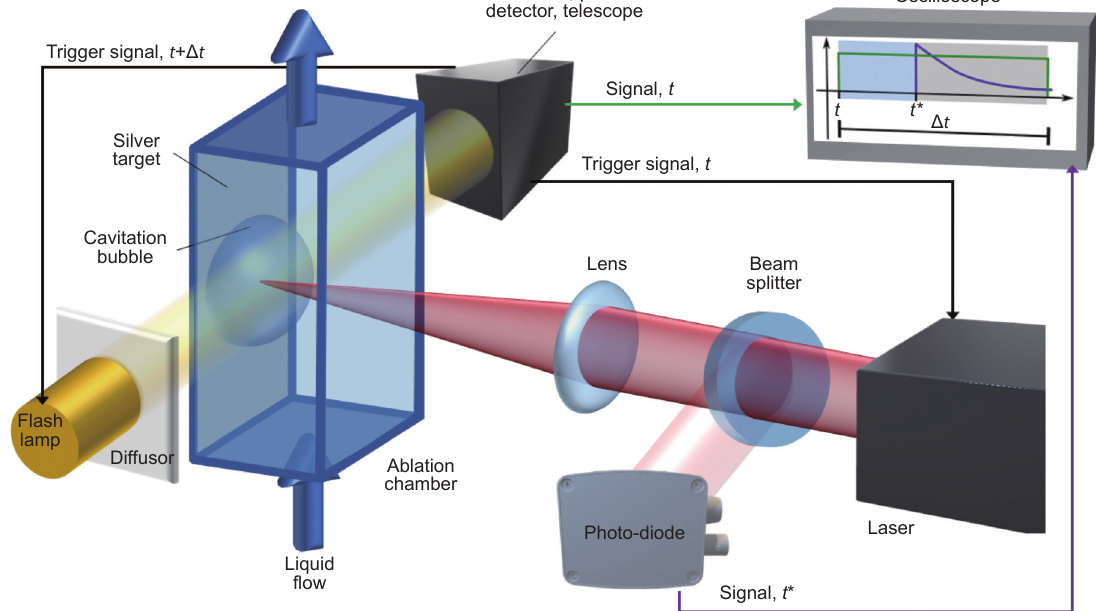
Fig. 1 | Shadowgraphy setup for cavitation bubble imaging during 1 ns, Q-switched laser ablation in water; the solid black lines repres- ent the trigger signals sent by the camera. Also, the signal of the camera and the photodiode are sent to an oscilloscope. In the exemplary os- cillogram, the camera and laser pulse signals are shown. The blue-shaded area in this diagram represents the laser's response time to the trig- ger signal and the gray-shaded area the resulting corrected delay time, which is the time between the laser pulse and the moment of image ac-